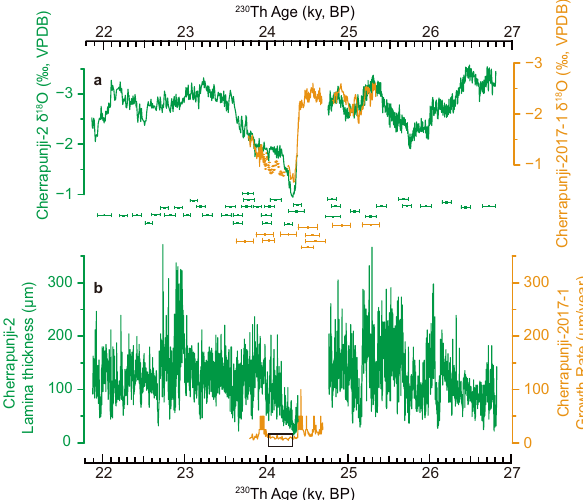
Fig. 1 | Cherrapunji Cave speleothem δ 18 O records. a Speleothem δ 18 O records from Cherrapunji Cave (Cherrapunji-2 and Cherrapunji-2017-1, this study) were used to construct a composite record. Over their contemporary growth intervals, we exclusively use the Cherrapunji-2 record (Supplementary Note 1.1). Error bars show 230 Th dates with uncertainties (2 σ ) for each record (color coded). b Annual laminathicknessofspeleothemCherrapunji-2andestimatedannualgrowthrateof speleothem Cherrapunji-2017-1. The black box in ( b ) shows the period with an extremelyslowgrowthrateinCherrapunji-2017-1,andthecorresponding δ 18 Odata in ( a ) is depicted by